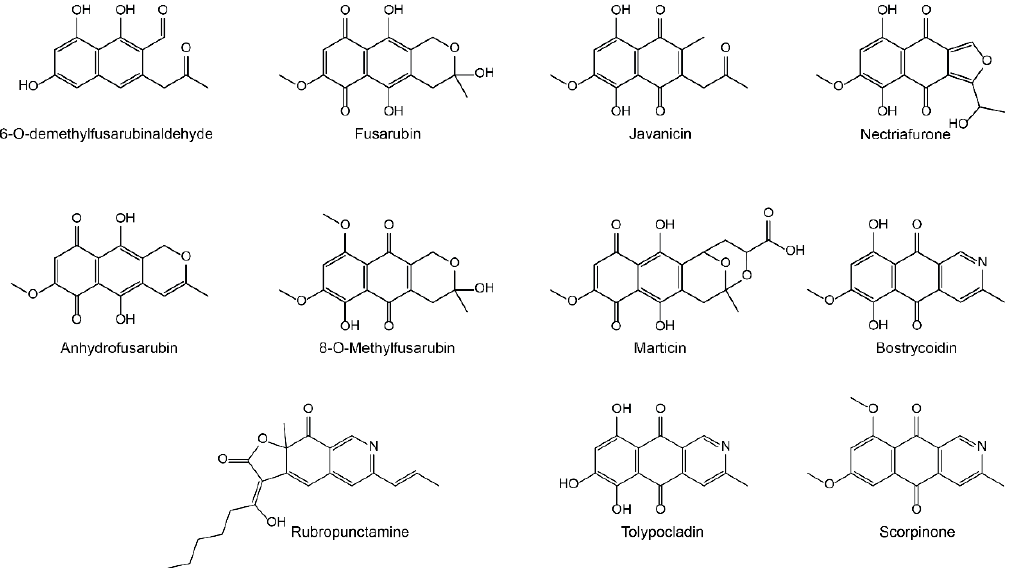
Figure 1. Structures of prominent fusarubins isolated from members of the Fusarium solani species complex as well as the structurally similar rubropunctamine from Monascus spp. [18], tolypocladin from Tolypocladium inflatum [19], and scorpinone from Amorosia littoralis